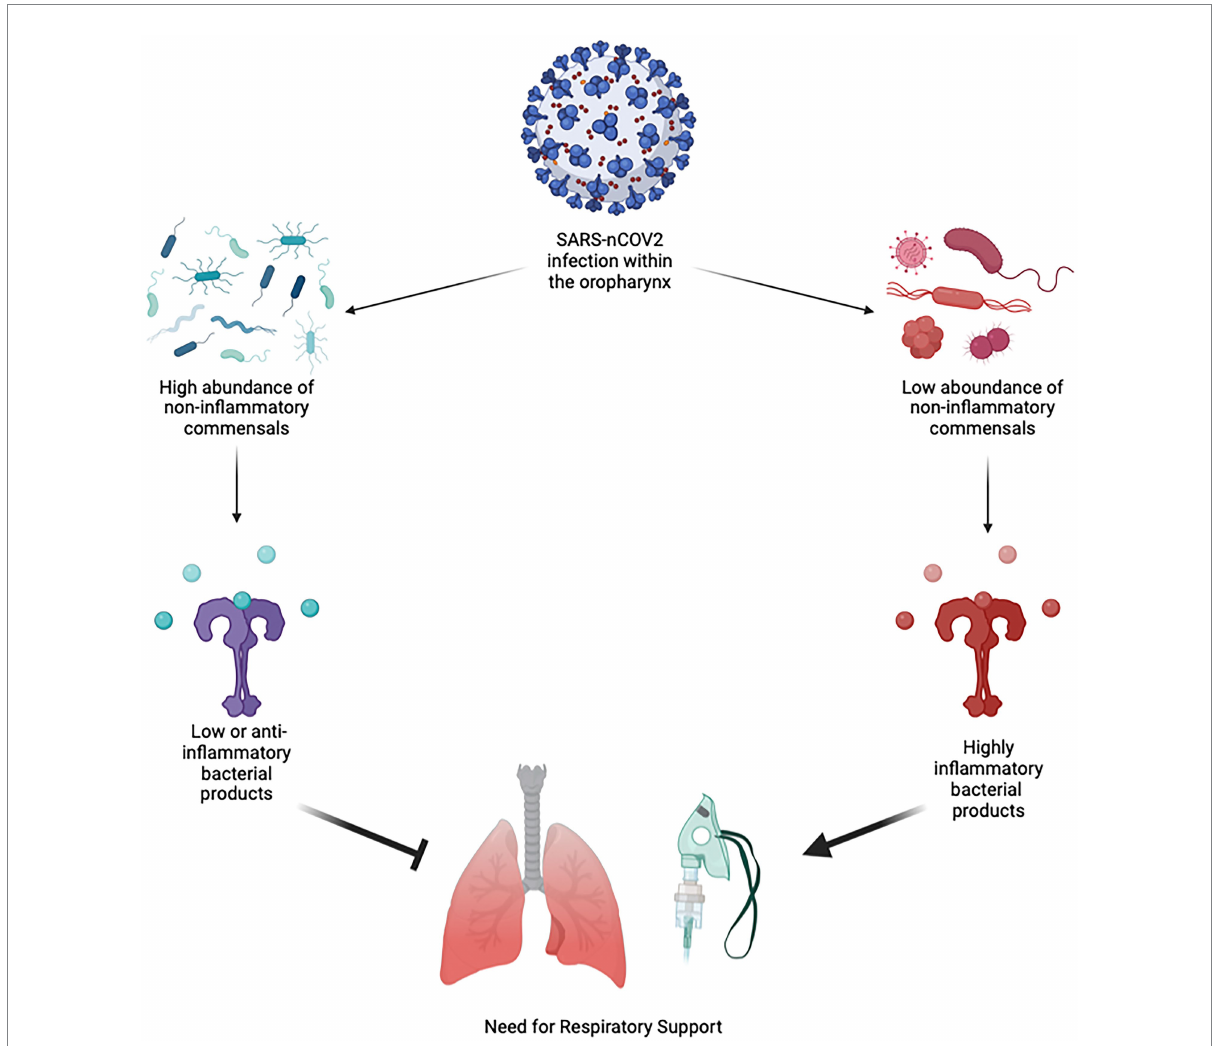
FIGURE 4 Conceptual Diagram of SARS-nCoV2 Interaction with the Oropharyngeal Microbiome. When an infection with SARS-nCoV2 begins within the oropharynx, it occurs within the environment of the microbiome. If the oropharyngeal microbiome has a high abundance of non-inflammatory or minimally inflammatory species that do not produce strongly inflammatory bacterial products, this will be protective against more severe lung disease and the need for respiratory support. If the oropharyngeal microbiome has a low abundance of non-inflammatory or minimally inflammatory species, then these produce more inflammatory bacterial products, leading to more severe lung disease and the need for respiratory